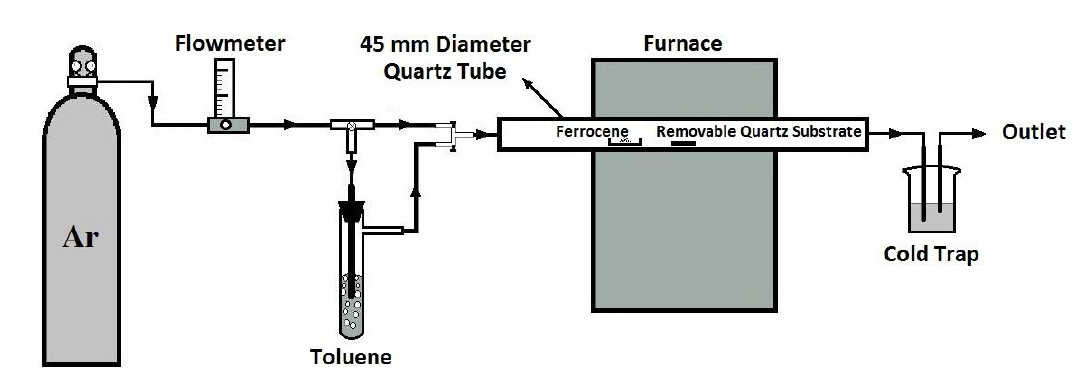
Figure 6. Schematic diagram of FC-CVD method for growing VA-CNTs (Mirbagheri et al., 2012)